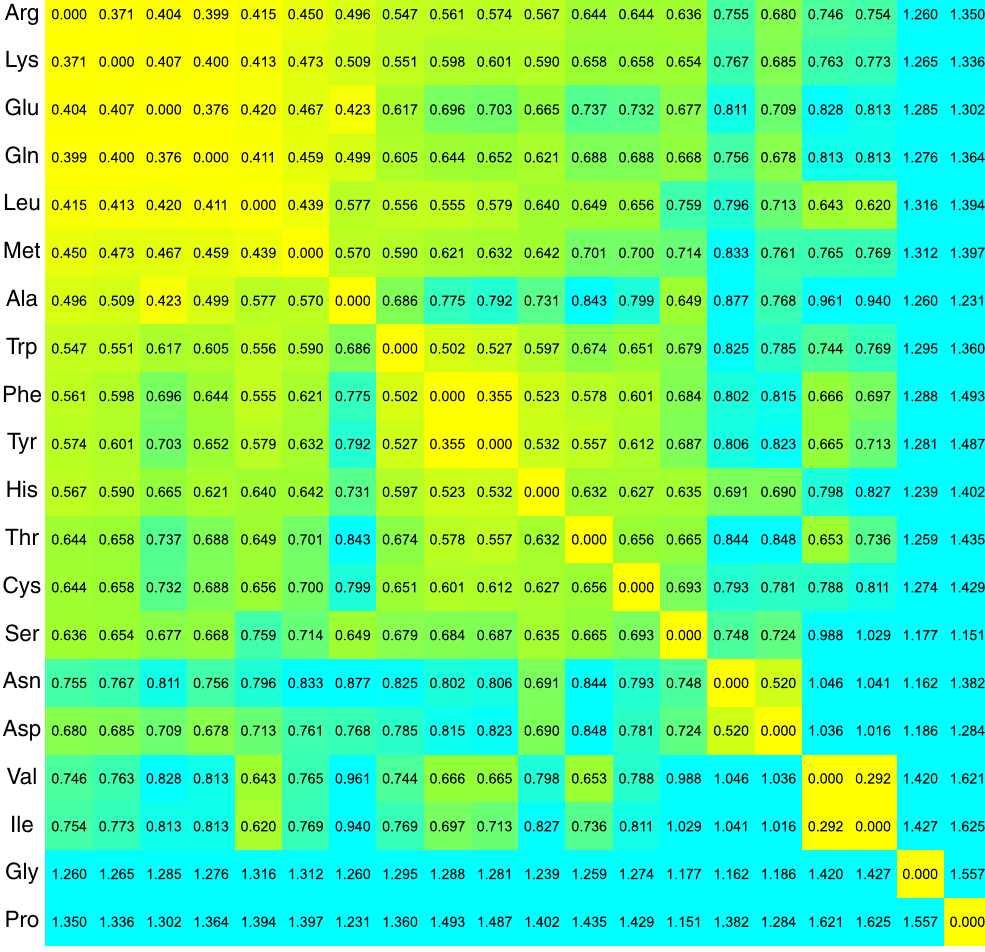
Figure 2. Distance matrix ordered according to structurally similar amino acids. The smallest distance is represented in yellow, and the largest distance in blue, with intermediate values in green. Open subsets appear, consistently, in yellow. Additionally, Gly, and Pro appear as the most distant elements, followed by Asn, Val-Ile, Ala, and